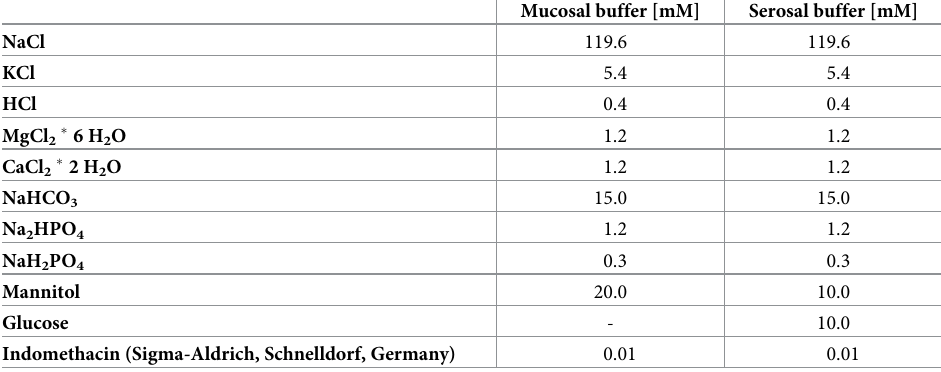
Table 1. Composition of buffer solutions used for Ussing chamber experiments (if not stated otherwise, all chemi- cals were obtained from Merck, Darmstadt, Germany). All chemicals were diluted in aqua